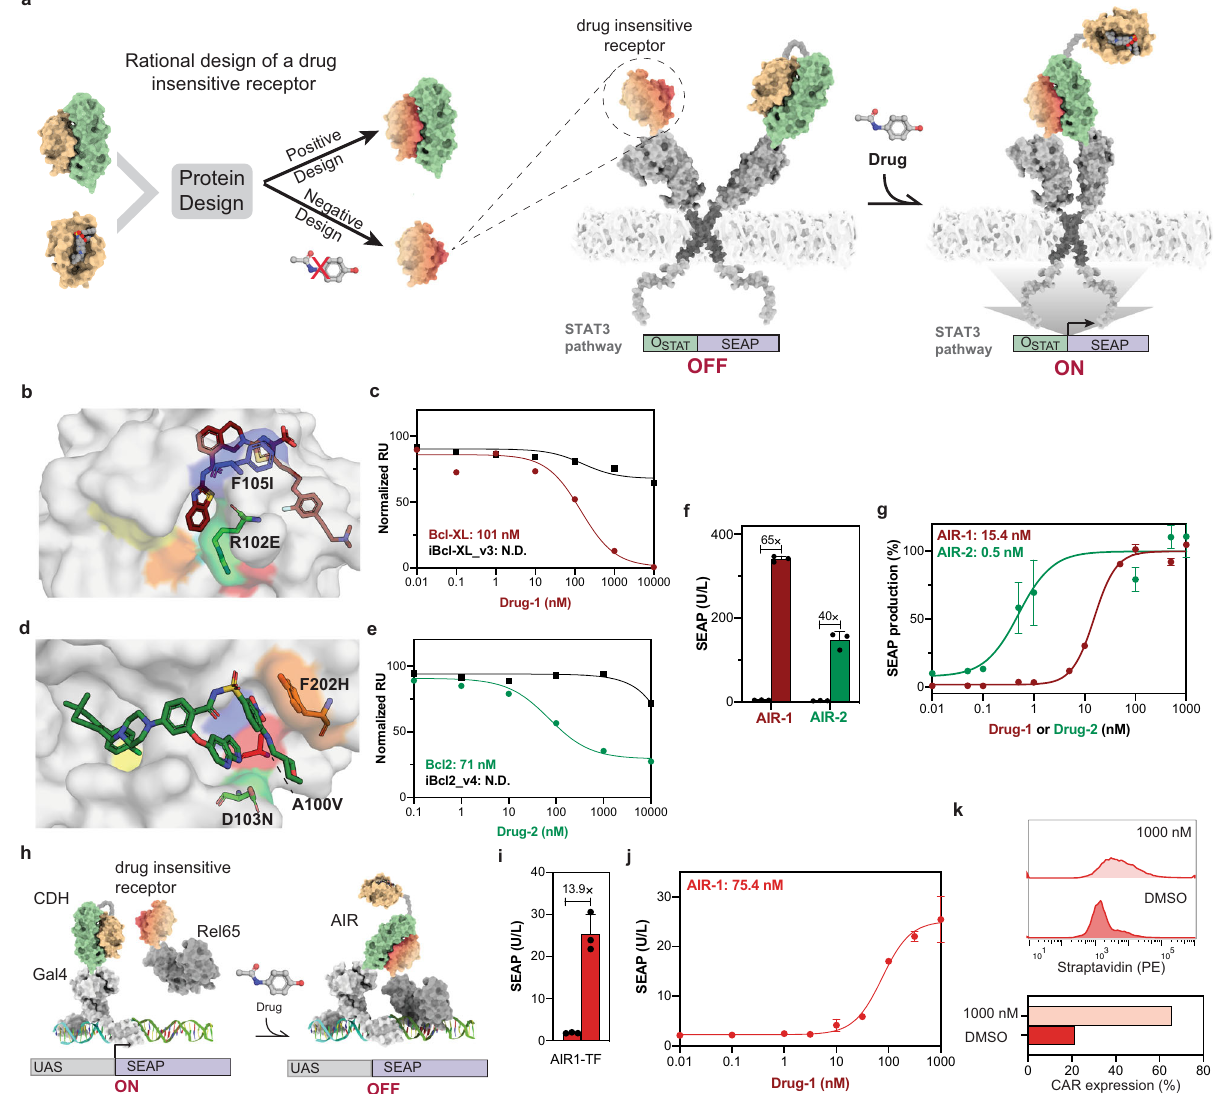
Fig. 4 Computational design of protein components to create chemically controlled ON-switches. a Computational design approach and architecture of the AIR-GEMS system. Starting from the CDH components (drug receptor (beige) and protein binder (green) we used a multistate design approach to search for drug-receptor variants that retained binding to the protein binder (positive design) and become resistant to the drug (negative design). We then assembled the AIR-GEMS, were the drug triggers the expression of SEAP by activating the JAK-STAT pathway. b Structural representation of Drug-1 binding pocket in Bcl-XL. Drug binding pocket (white surface) where the mutations R102E (green sticks) and F105I (blue sticks) were performed to obtain the variant iBcl-XL_v3. Drug-1 is shown in sticks representation and colored in brown. Four other designable residues are highlighted on the surface, E98 in red, T109 in cyan, S145 in orange and A149 in yellow. c Apparent IC 50 s for Drug-1 induce dissociation of Bcl-XL:LD3 and iBcl-XL_v3:LD3 determined by SPR drug competition assay. d Structural representation of Drug-1 binding pocket in Bcl2. Drug binding pocket (white surface) where the mutations A100V (red sticks), D103N (green sticks) and Y201H (orange sticks) were performed to obtain the variant iBcl2_v4. Drug-2 is shown in sticks representation and colored in green. Two other designable resides are highlighted on the surface, V148 in blue, V156 in yellow. e Apparent IC 50 s of Drug-2 induce dissociation of Bcl2:LD3 and iBcl2_v4:LD3 determined by SPR drug competition assay. f AIR-GEMS fold-change activity between drug (1 µ M) versus no drug treatment (DMSO), showing the quanti fi cation of SEAP expression after 24 h. Each bar represents the mean of three biological replicates ± s.d, overlaid with a scatter dot plot of the original data points. g Drug dose-dependent responses in engineered cells expressing the AIR-GEMS. Each data point represents the mean ± s.d. of three replicates and the EC 50 s were calculated using four-parameter nonlinear regression. h Schematic representation of the AIRs utilized to control transcription regulation with the GAL4/UAS system (AIR-TFs). i AIR-1-TF fold-change activity between drug treated (1 µ M) versus untreated (DMSO), showing the quanti fi cation of SEAP expression after 24 h drug treatment. Each bar shows the mean of three biological replicates ± s.d, overlaid the original data points. j Drug dose-dependent responses of AIR-1-TF quanti fi ed by SEAP expression after 24 h drug treatment. Each data point represents the mean of n = 3 biological replicates, and the EC 50 s were calculated using four-parameter nonlinear regression. k AIR-1-TF induces CAR expression comparison between treated (1 µ M) versus untreated (DMSO). Histogram of fl ow cytometry (up) and quanti fi cation of CAR expressing cells (bottom). f , g , i , j , k Source data are available in the source data fi